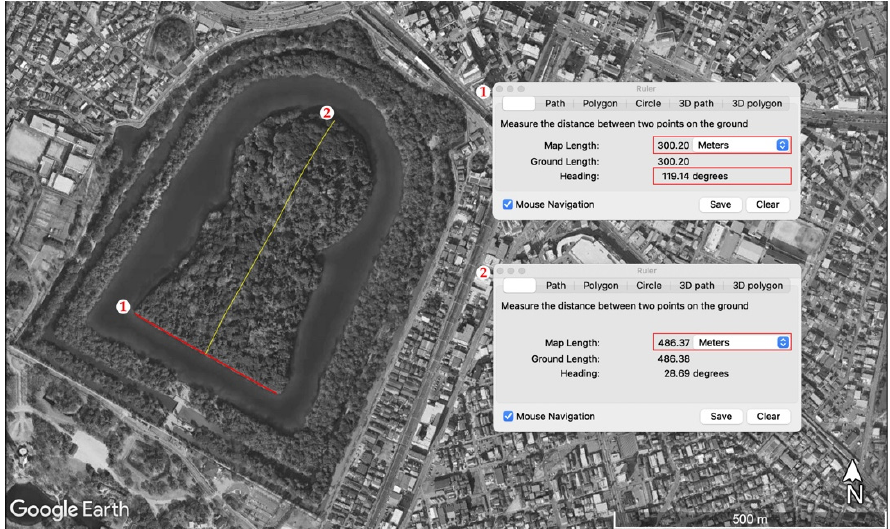
Figure 3. Example of measurements: orientation with respect to north, length of the baseline, and transversal length of the Daisen Kofun. (Image courtesy of Google Earth, edited by the authors).